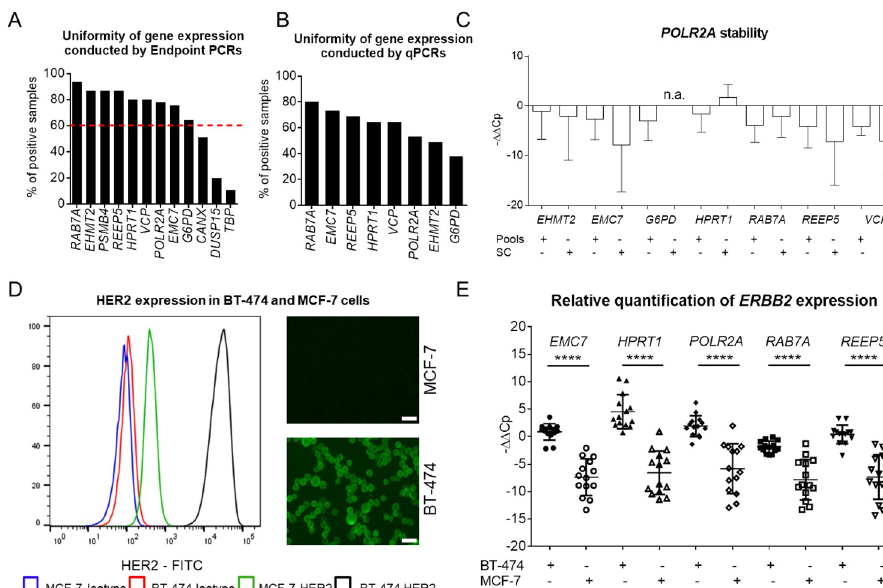
Fig 1. Relative qPCR quantification of single cell transcripts. (A) Stable and uniform gene expression (depicted as the percentage of samples tested positive for selected transcripts) of twelve genes examined by endpoint PCRs of WTA products obtained from three sample sets including cell pools and single cells. The red dashed line indicates the threshold for further testing (60%). (B) Uniformity of gene expression (%) of the remaining eight candidate reference genes as measured by qPCR. (C) Stability of gene expression depicted as - ΔΔ Cp (log2-transformed ratios) calculated for POLR2A vs the remaining candidate genes. The expression of G6PD could not be measured in single cells (n.a. = not assessed). SC = single-cell WTA products, Pools = WTA products generated from a pool of cells. (D) HER2 expression in BT-474 and MCF-7 breast cancer cells analyzed by FACS (left panel) and microscopically (right panels). HER2 expression was 62-fold higher in BT-474 as compared to MCF-7 cells. Median FITC (BT-474) = 24,659; Median FITC (MCF-7) = 399. Microscope settings corrections: Brightness: +20%, contrast: -40%; Scale bar 20 μ m. (E) Relative quantification of ERBB2 expression at the single-cell level in BT-474 and MCF-7 cells calculated separately using single reference genes as indicated. - ΔΔ Cp were calculated and plotted for every single-cell qPCR measurement. Mean ± SD of - ΔΔ Cp values; Unpaired t-test with Welch’s correction; ��� p < 0.001, ���� p < 0.0001.